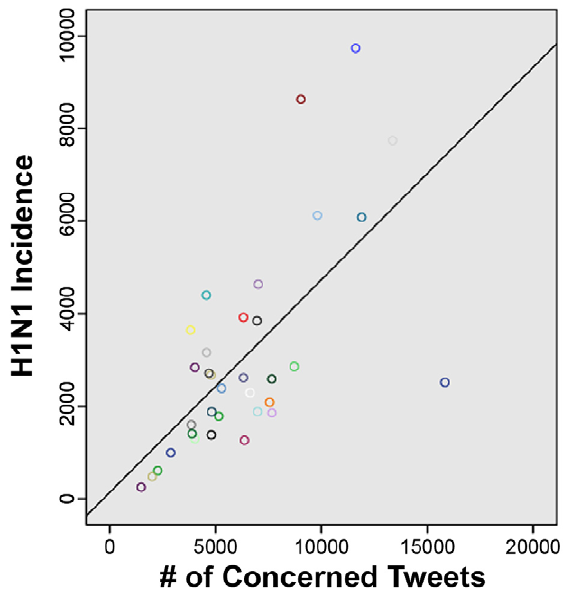
Figure 5. Scatterplot of tweets expressing concern and USA H1N1 incidence